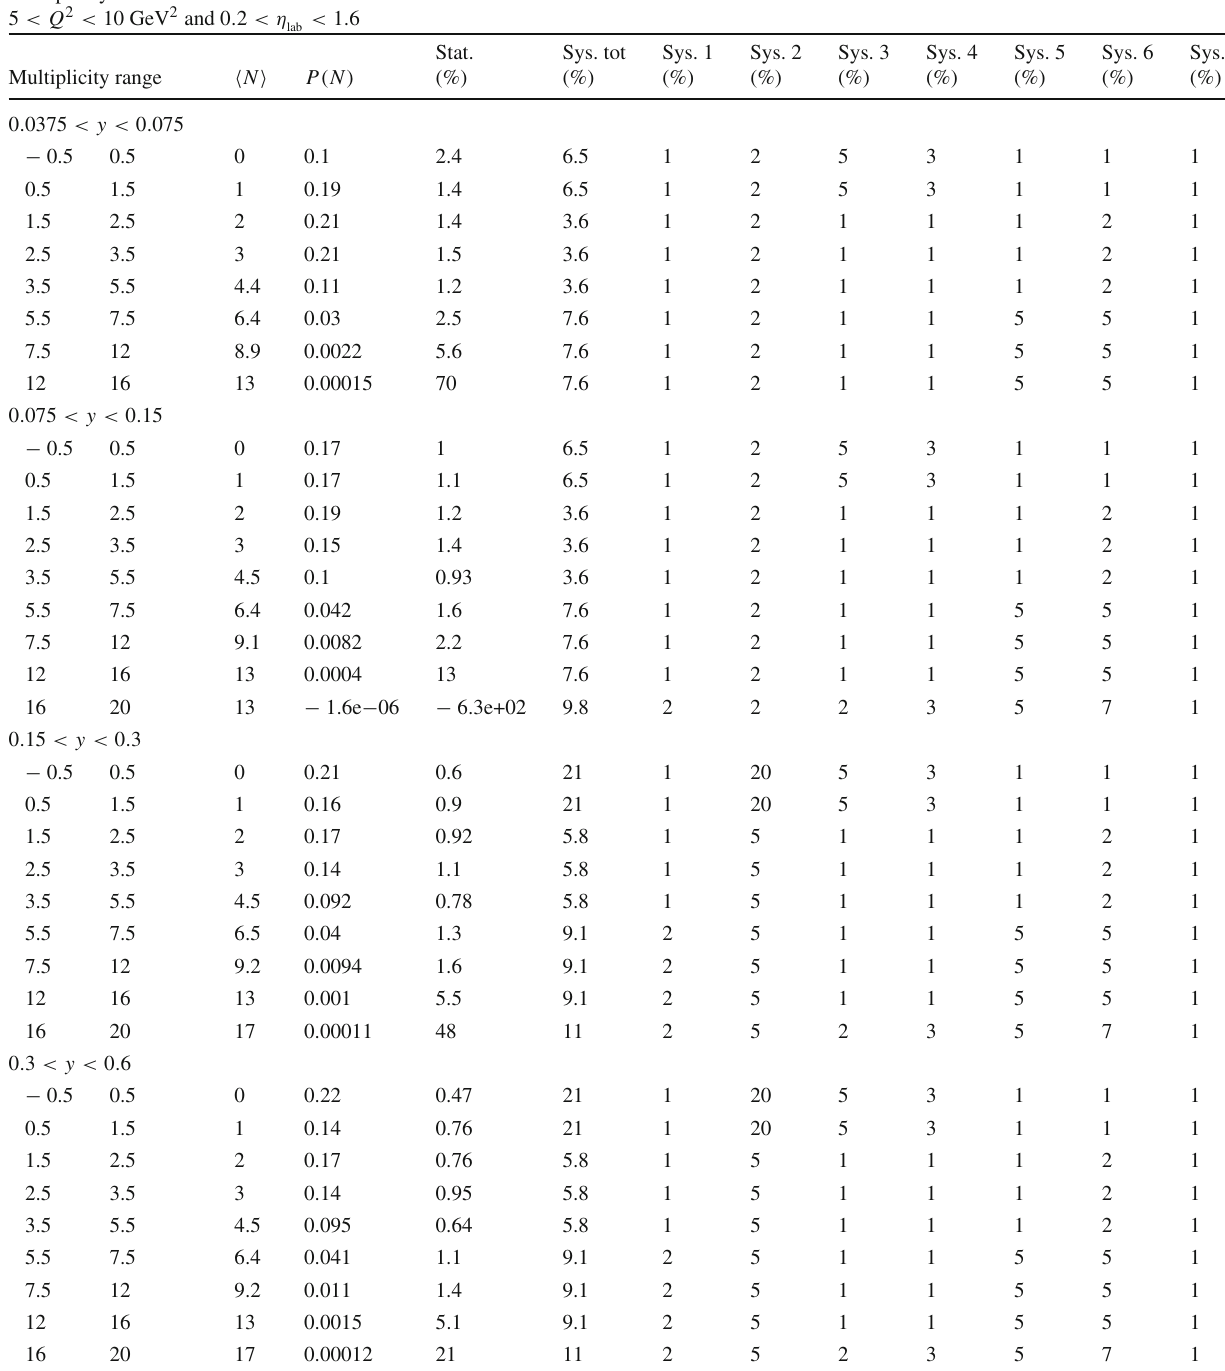
Table 15 Charged particle multiplicity distributions P ( N ) measured √ s = 319GeV with in the ranges of photon virtual- in ep DIS at ity 5 < Q 2 < 10 GeV 2 and charged particle pseudorapidity range Multiplicity distributions in DIS < 1 . 5 < Q 2 < 10 GeV 2 and 0 . 2 < η lab